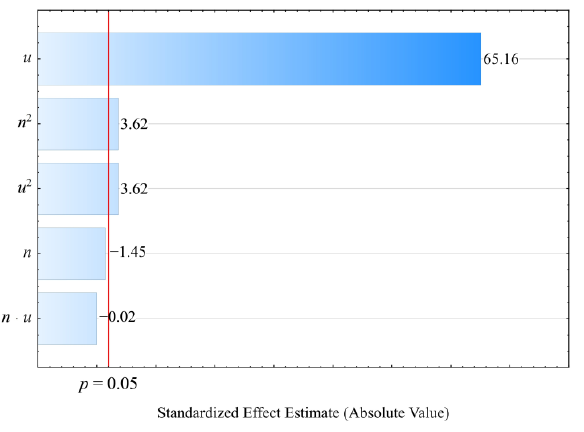
Figure 22. Pareto plots of the standardized effects of empirical full model Young’s modulus E ; the vertical line in the plot corresponds to the arbitrarily chosen level of significance ( p = 0.05). Table 14. Model of Young’s modulus E —ANOVA table, R 2 = 0.99; R adj2 = 0.99.